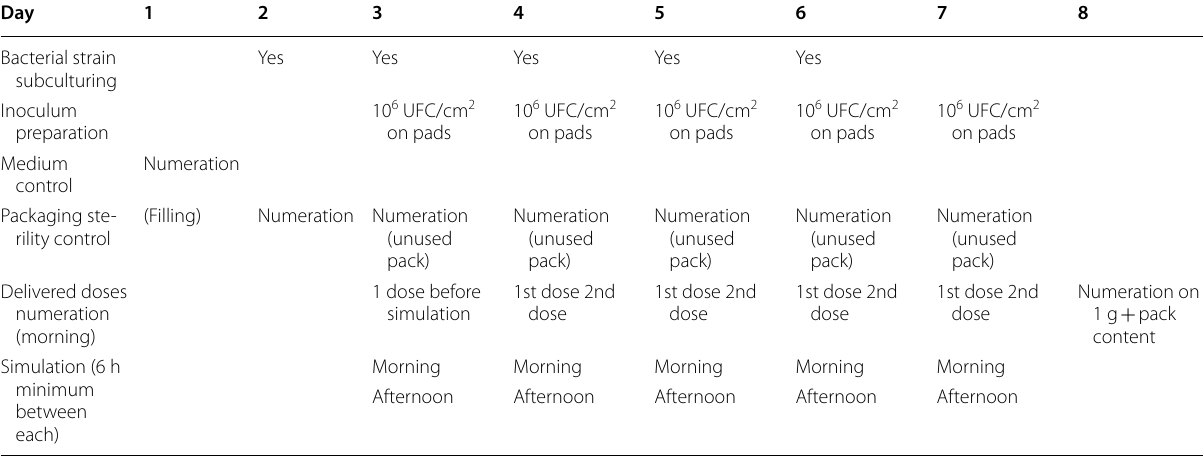
Table 1 Schedule of the simulation contamination